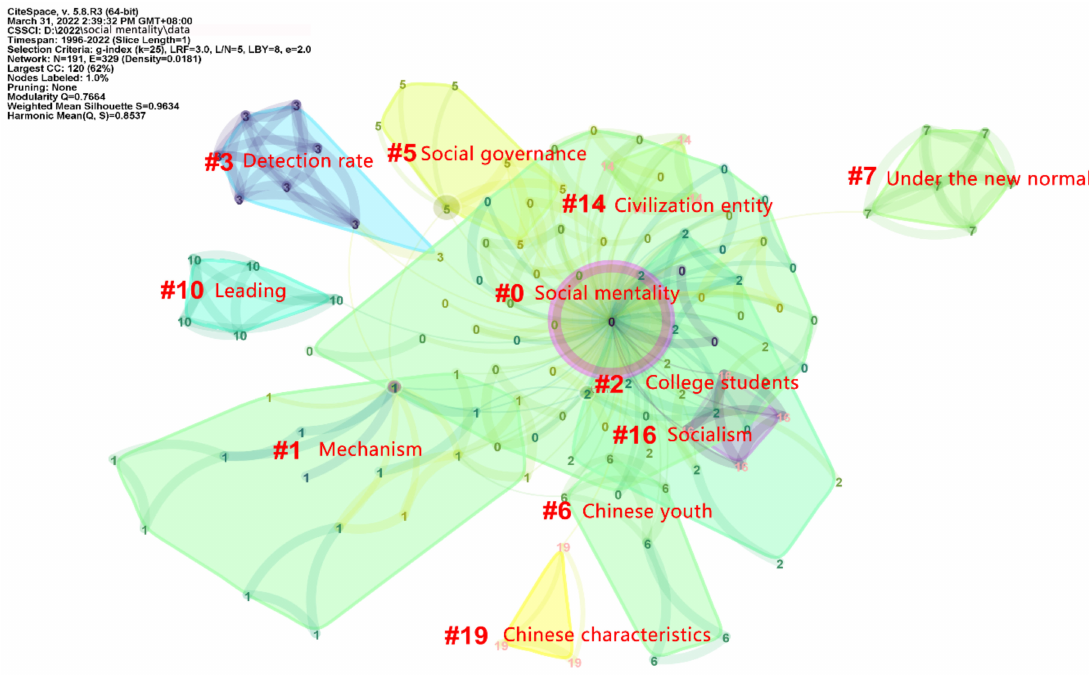
Figure 4. Clustering map of keywords on social mentality and health in the CNKI database